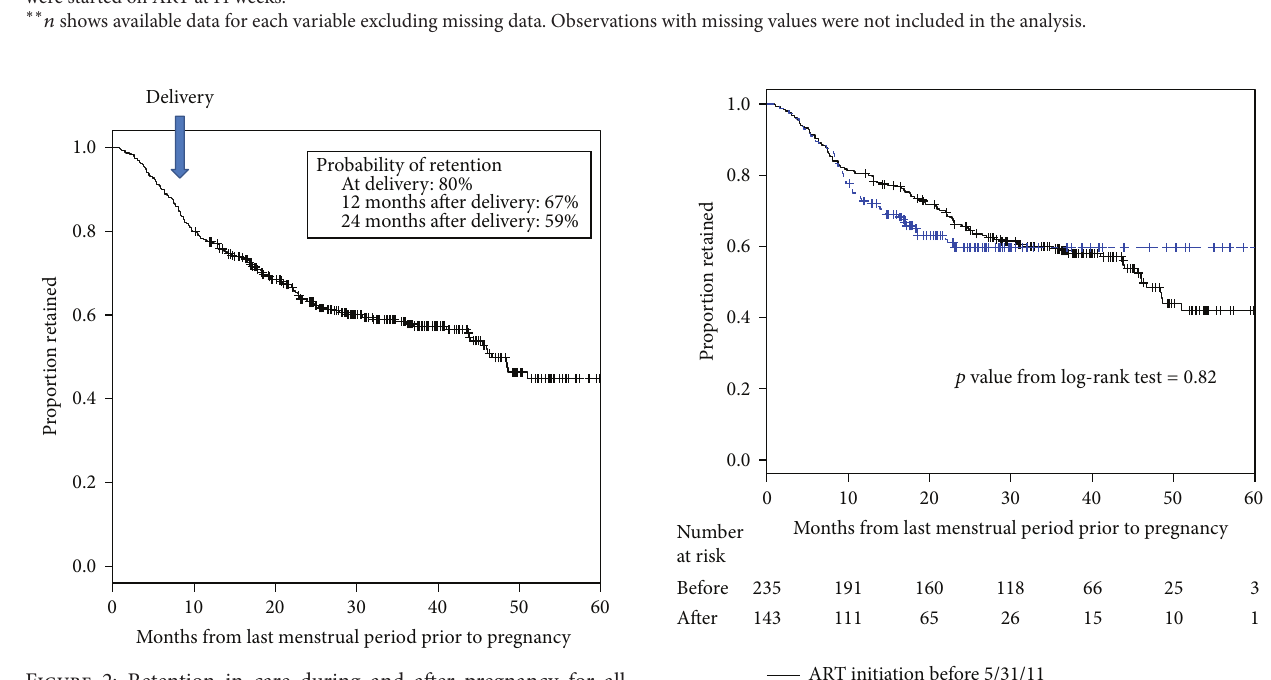
Figure 2: Retention in care during and after pregnancy for all women.